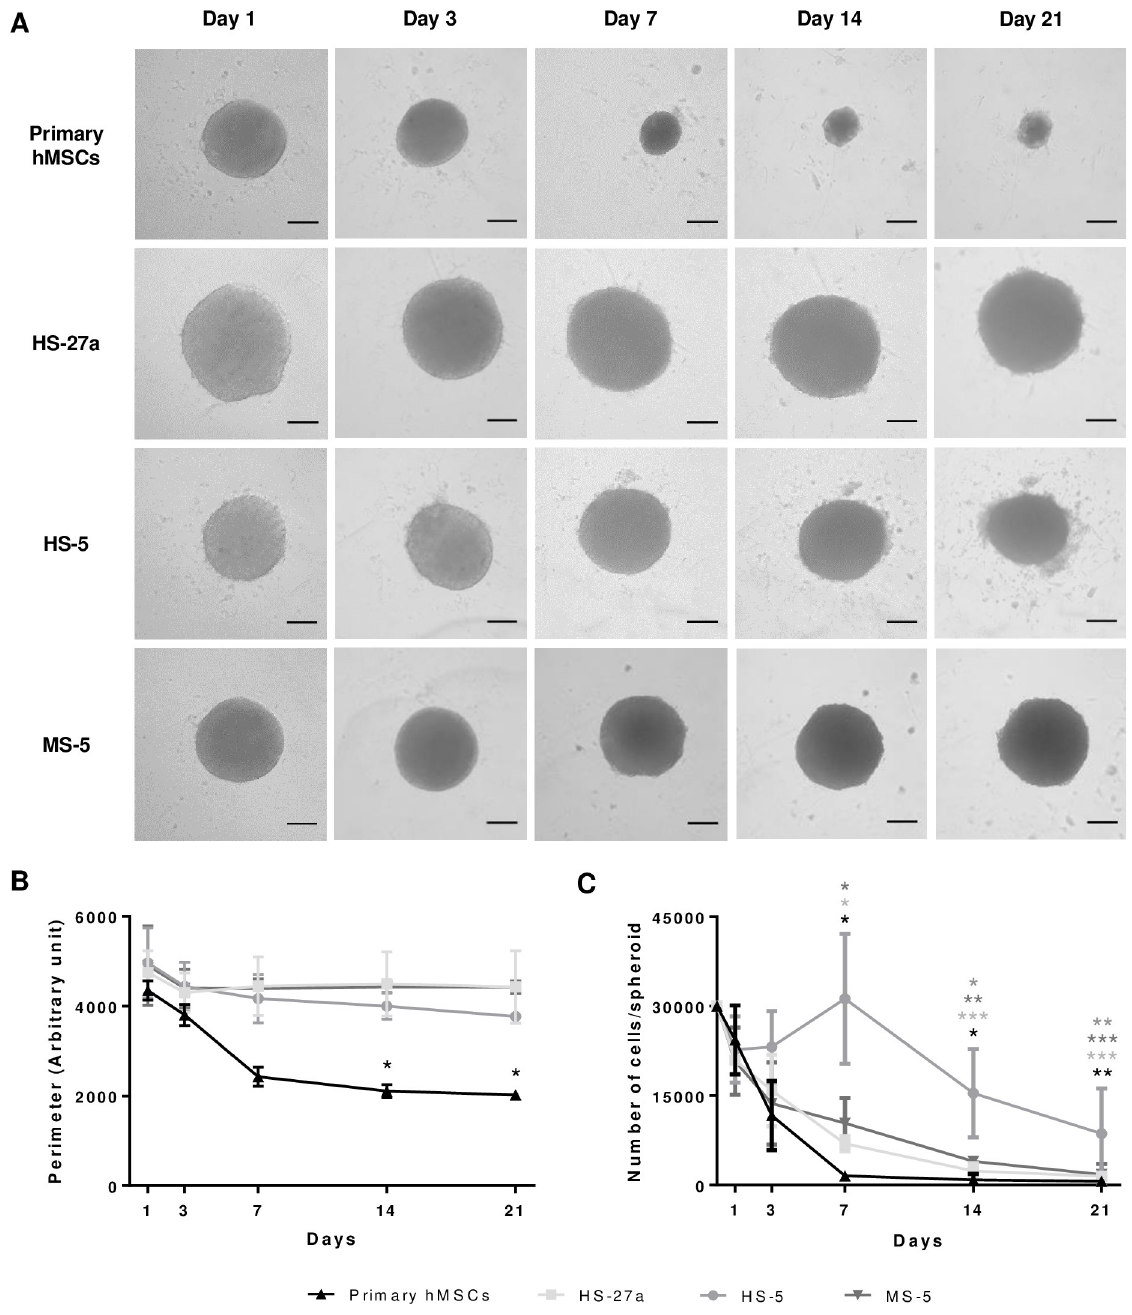
Fig 2. Follow up of the spheroids from various MSCs. (A) Microscopy analysis of primary hMSC-, HS-27a-, HS-5- and MS-5-spheroids over 21 days in culture (scale bars = 100 μ m). (B) Perimeter was measured with an arbitrary unit; each experiment is the mean of at least 10 spheroids from n = 3 experiments. Data are shown as mean ± SD; � compared to day 1; � p � 0.01. (C) Number of living cells per spheroid over 21 days in culture (primary hMCSs and MS-5 n = 3; HS-27a and HS-5 n = 4). Data are shown as mean ± SD; � , �� , ��� compared to day 0; � p � 0.05; �� p � 0.01; ��� p �